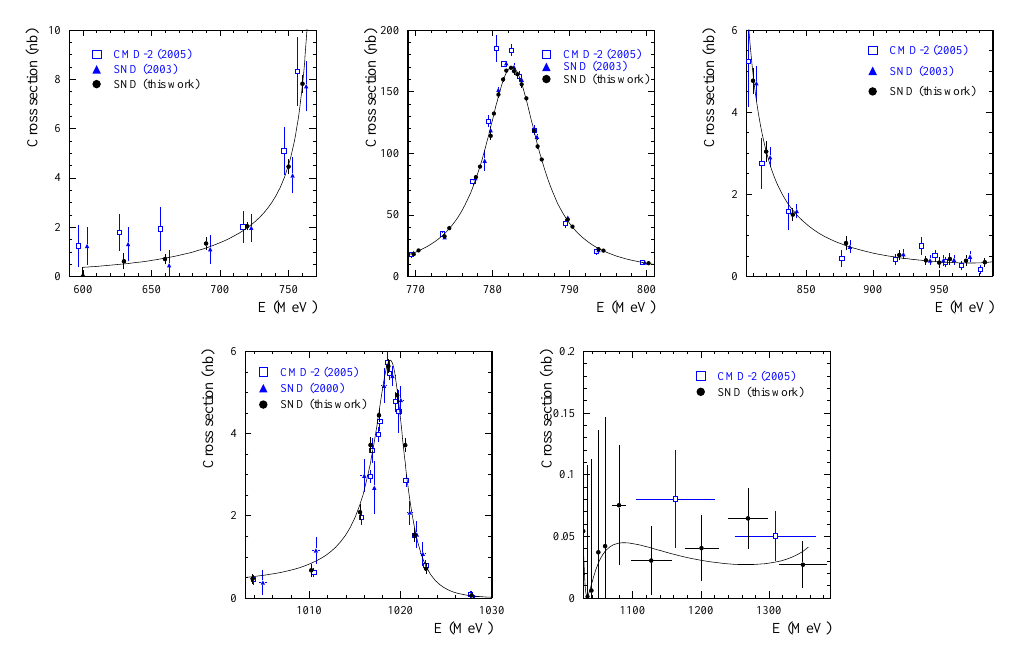
Figure 1. The e + e − → π 0 γ cross section measured by SND [5] in di ff erent energy regions in comparison with the previous most accurate measurements: SND (2000) [6], SND (2003) [7], and CMD-2 (2005) [8]. The curve is the result of the